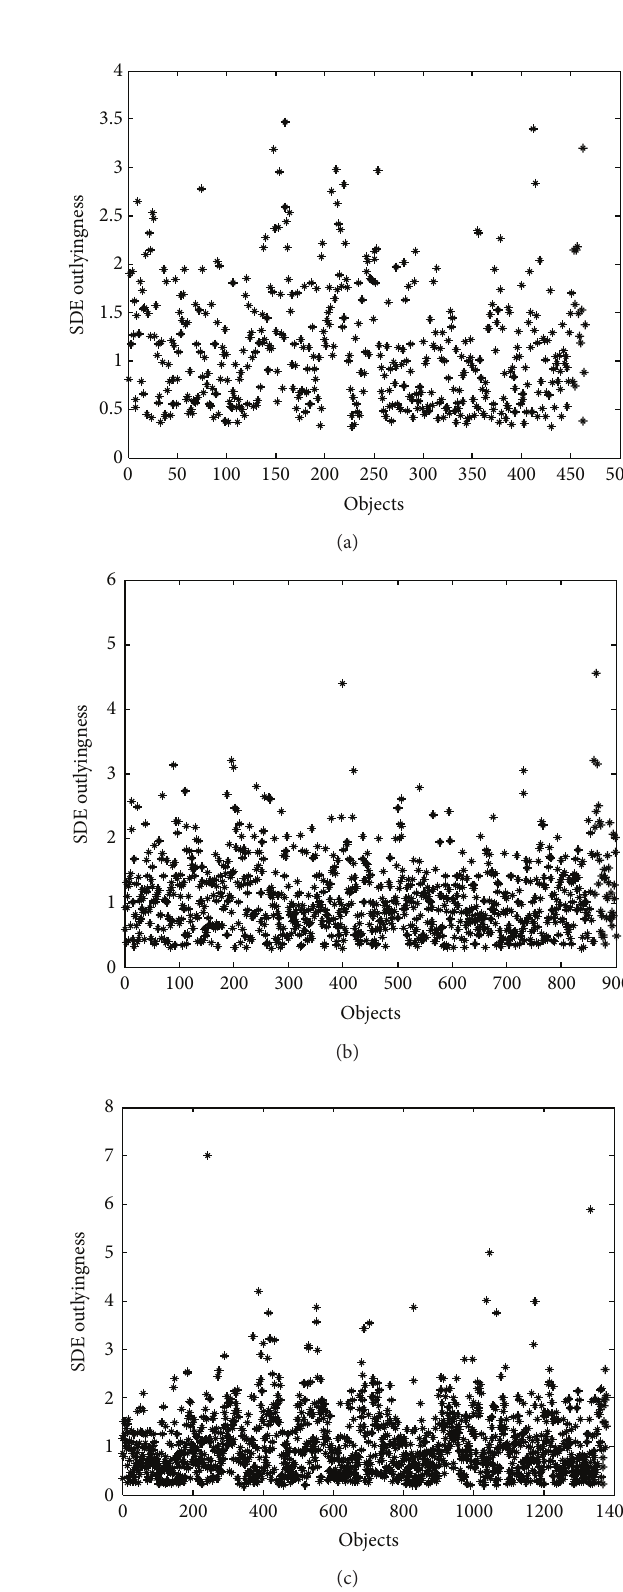
Figure 2: NIR spectra of Longjing tea preprocessed by (a) smooth- ing, (b) second-order derivatives and (c) SNV. An artificial shift was added to distinguish different grades (I, II, and III) of Longjing.